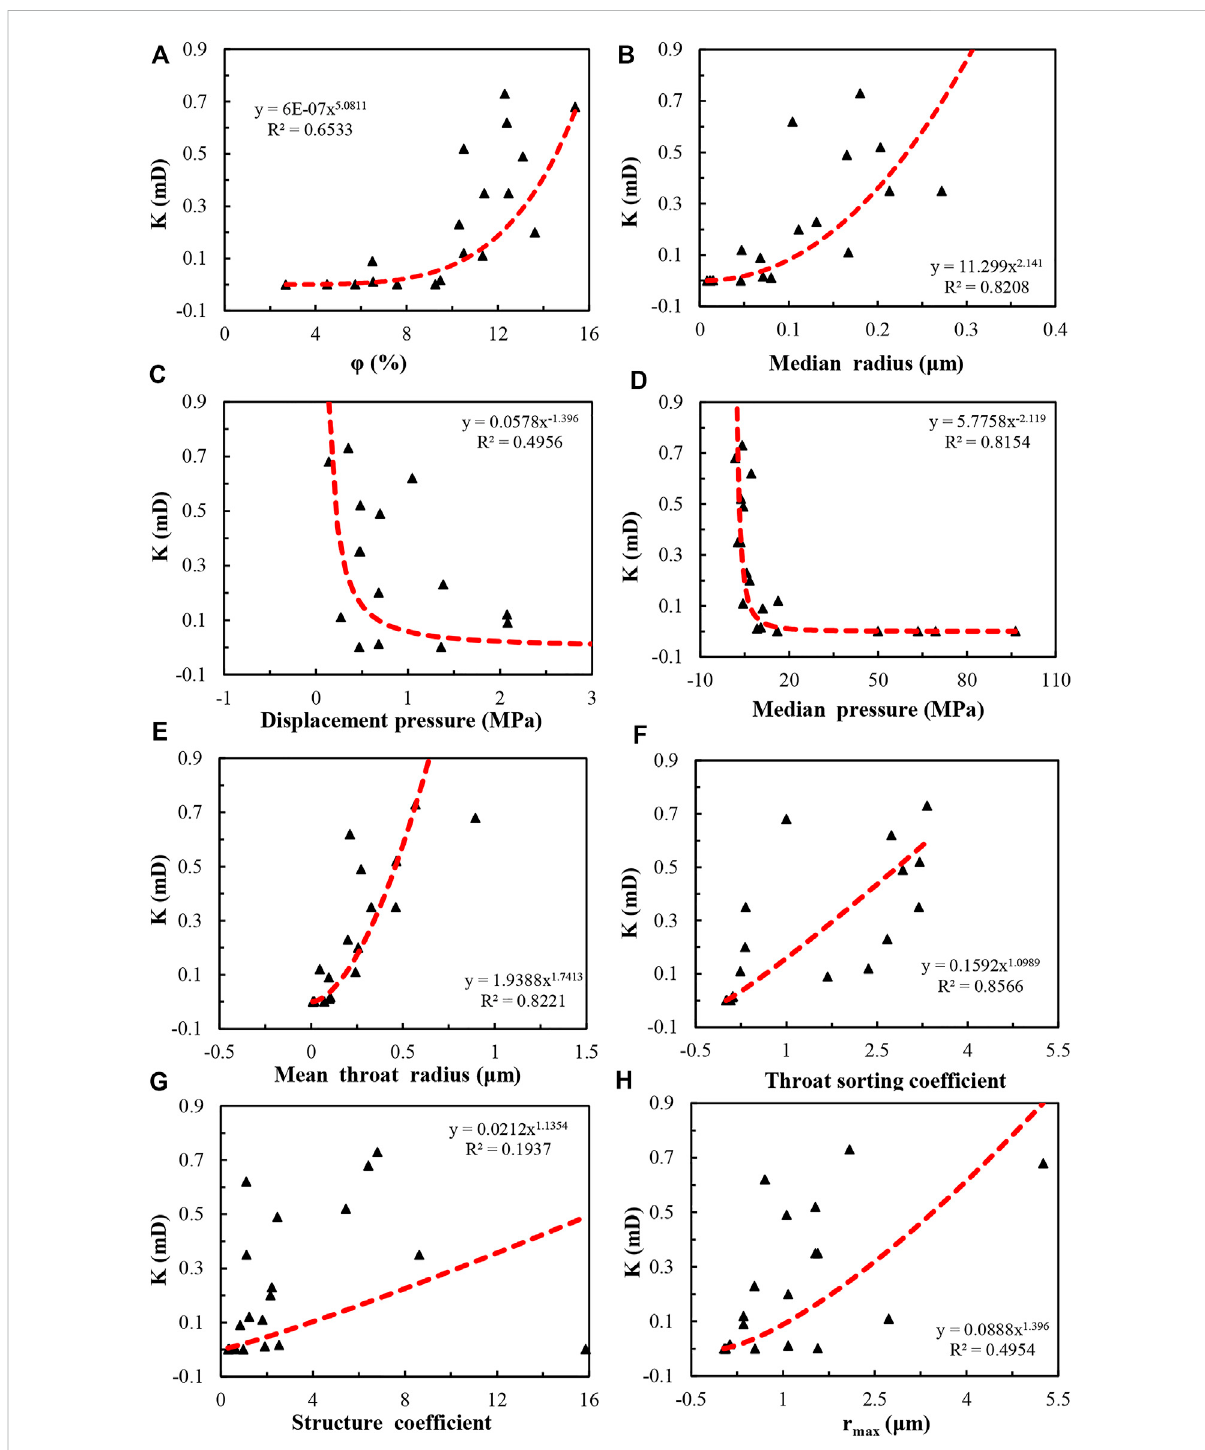
FIGURE 10 Correlations between permeability and pore structure